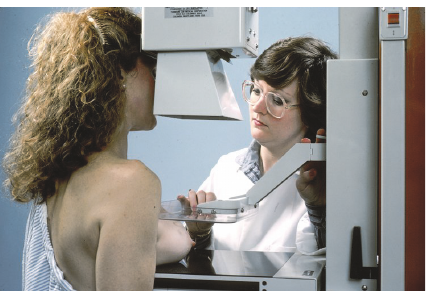
Figure 1: Mammogram examination [7], National Cancer Institute, Public Domain https://commons.wikimedia.org/wiki/File:Mam-